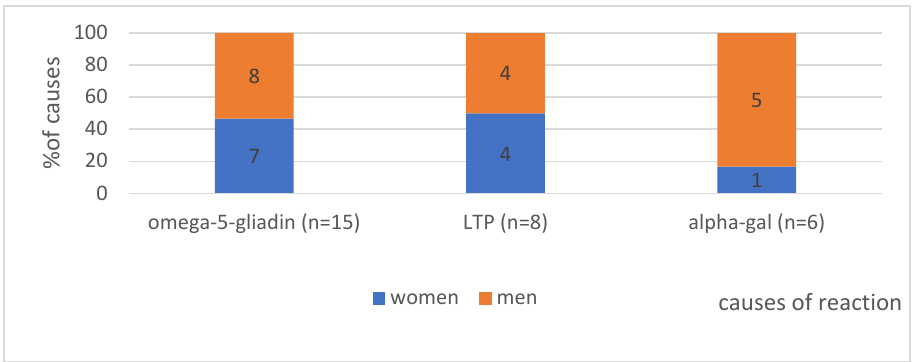
Figure 1. The gender distribution in analysed group with division into individual causes. Absolute values of numbers of patients are given in the diagram.